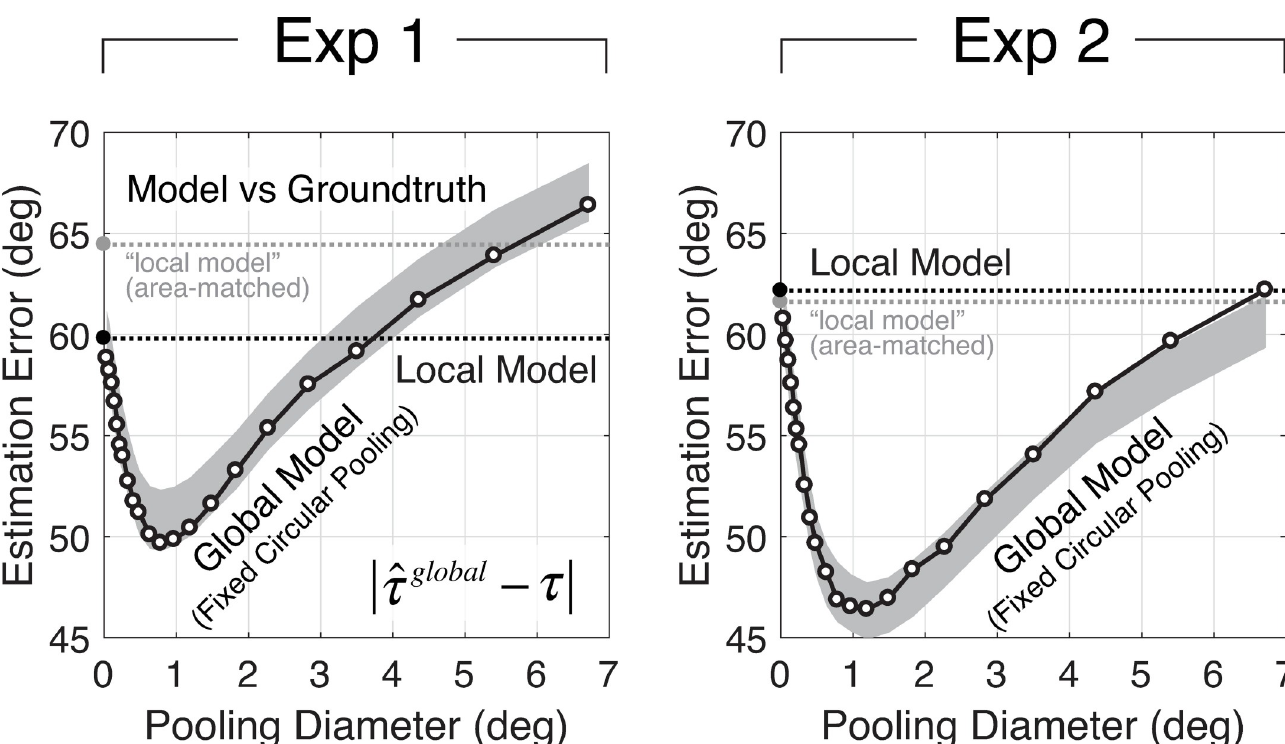
Fig 7. Groundtruth tilt estimation error from the global model with fixed circular pooling. Mean estimation error is plotted as a function of the diameter of pooling region. Mean estimation errors are computed across all tilts. The black dashed line indicates the mean estimation error for the local model; the local model does not pool local estimates and thus has a pooling diameter of 0 º . The gray dashed line indicates the estimation error for a “local” model that computes the image cues from an area matched to that implicitly used by the best global model (see Discussion). Monte Carlo simulations on 1000 randomly sampled stimulus sets were used to obtain 95% confidence intervals on the mean estimation error (gray area). Data from Exp 1 and Exp 2 are shown in the left and right columns, respectively.